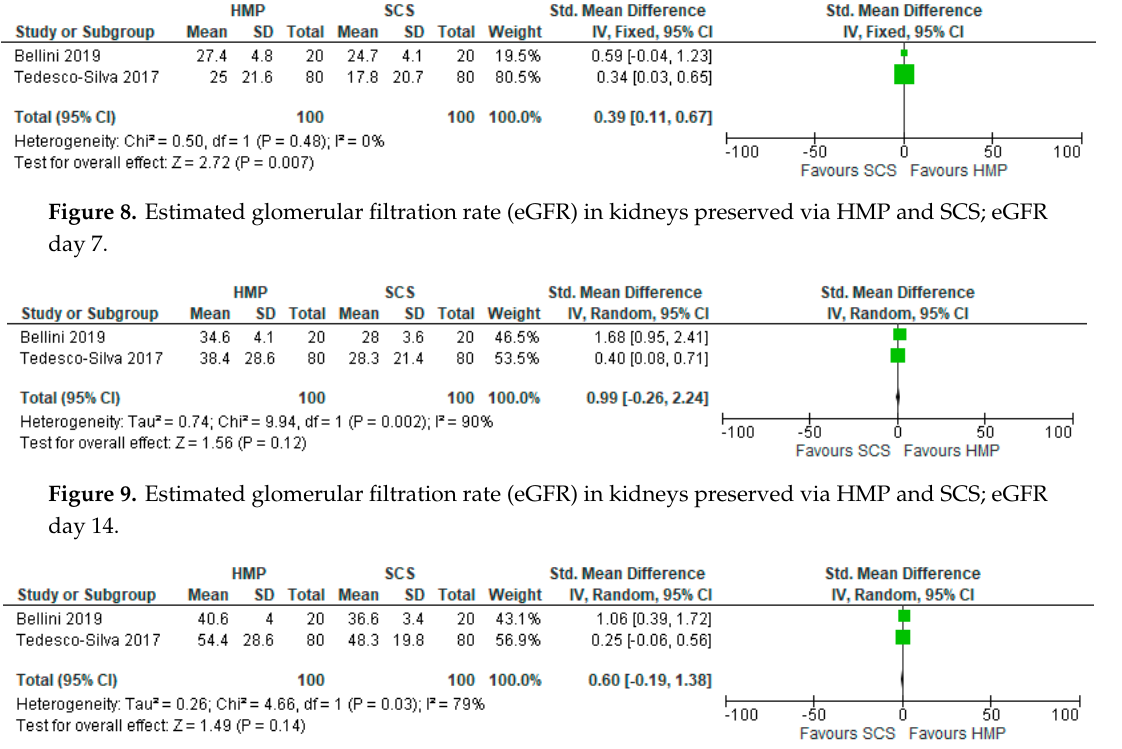
Figure 11. Primary nonfunction in livers preserved via HMP and SCS. Figure 12. Primary nonfunction in livers preserved via HMP and SCS. 3.12. Early Allograft Dysfunction Four studies [28–31] compared EAD prevalence in livers stored using HMP and SCS (206 patients). Overall, livers stored with HMP showed lower prevalence of EAD (OR: 0.36 95% CI 0.17 to 0.75, p = 0.006) (Figure 13). Similar results were reported by the three studies comparing EAD